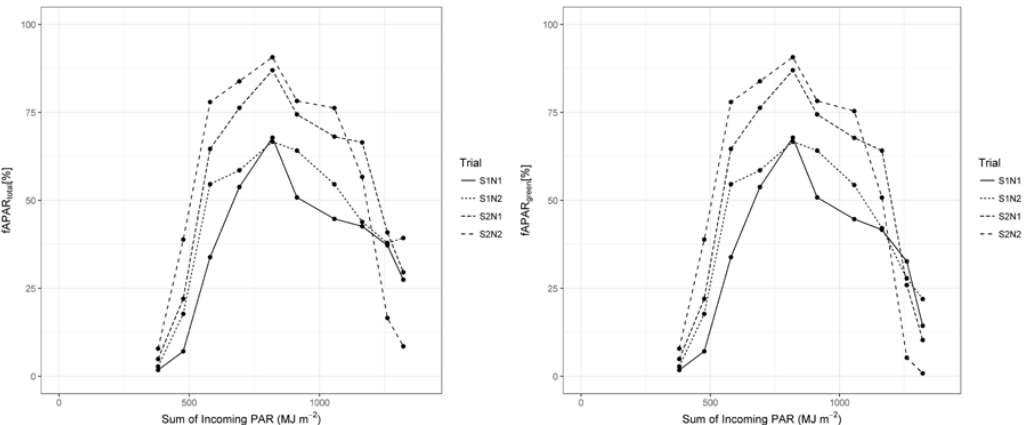
Figure 6. fAPARtotal ( left ) and fAPARgreen ( right ) vs. Sum of Incoming PAR. Each line represents one treatment.